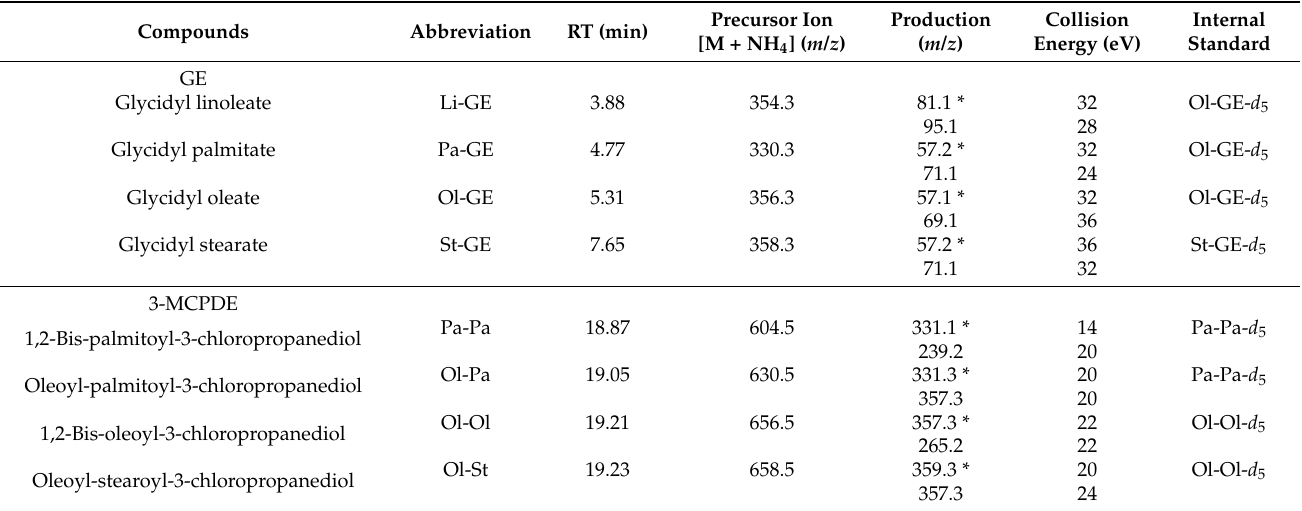
Table 1. MS parameters for GE and